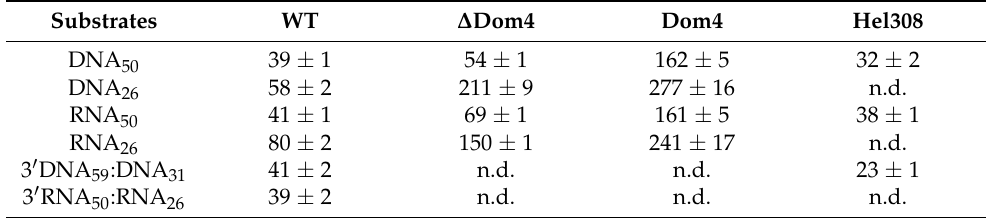
Table 1. Apparent dissociation constant (Kd in nM) derived from data shown in Figure 6 (n.d. means not